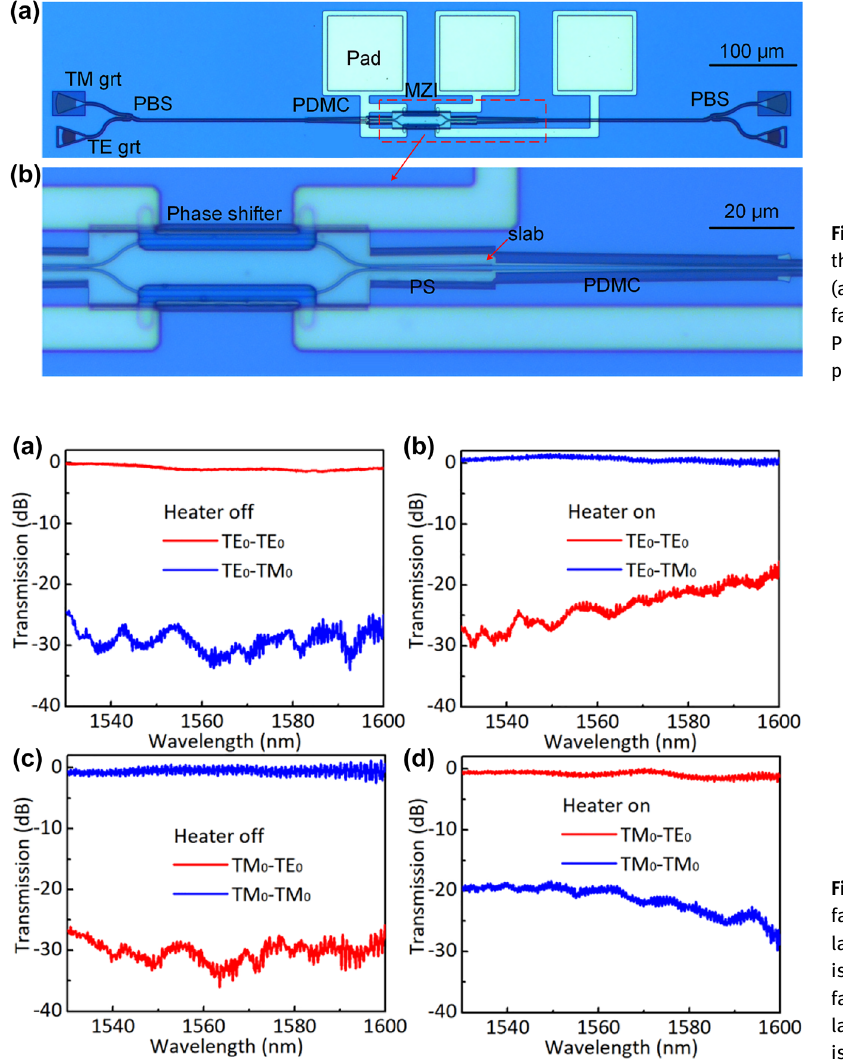
Figure 10: Measured transmissions of the fabricated polarization switch for the launched TE 0 (a) and TM 0 (b) modes when it is off; measured transmissions of the fabricated polarization switch for the launched TE 0 (c) and TM 0 (d) modes when it is on.